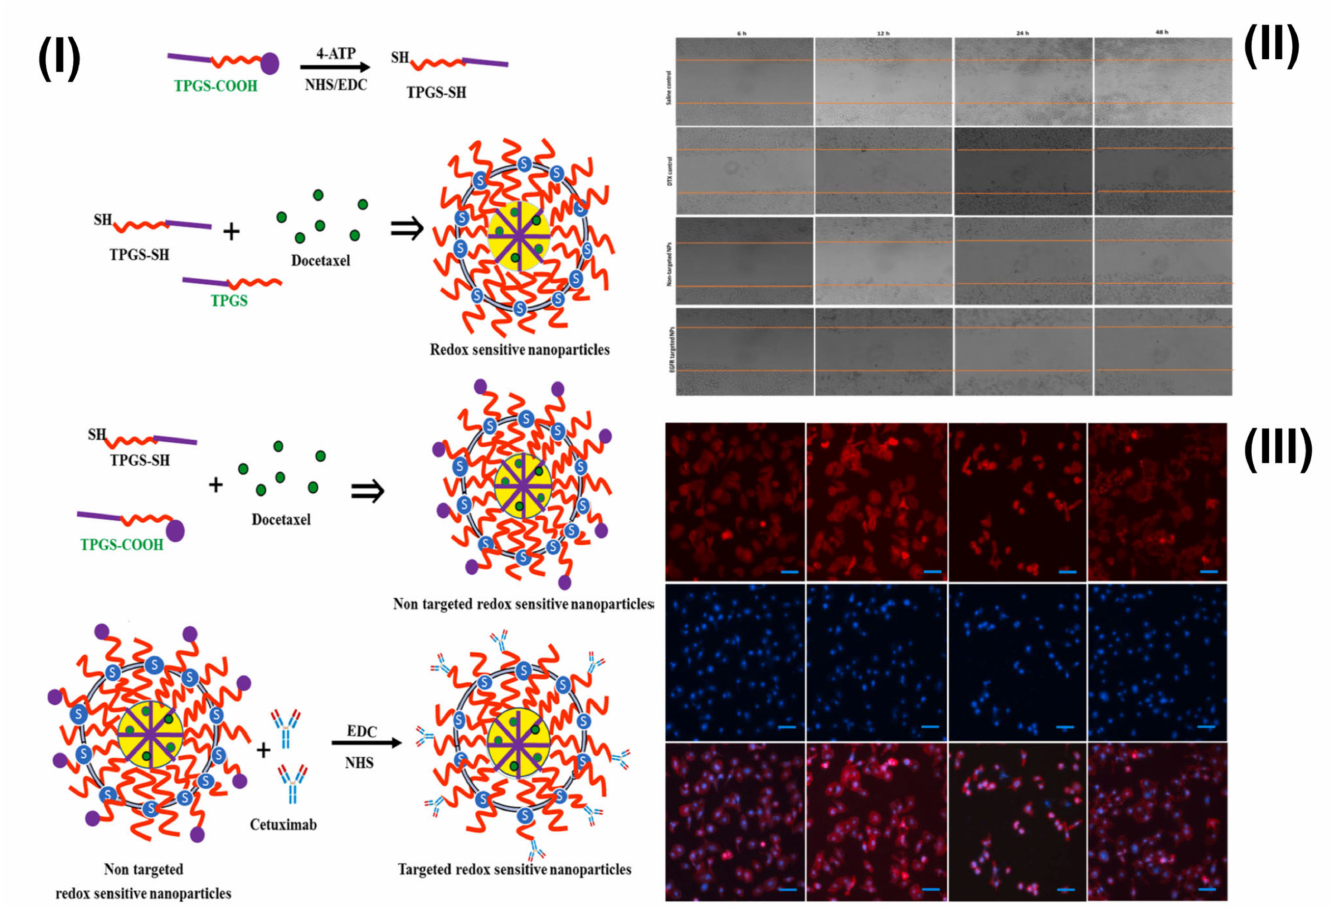
Figure 6. ( I ) Method for making redox-sensitive NPs that can be used in specific applications are described; ( II ) Wound healing assay (in vitro); ( III ) apoptosis studies (in vitro). Reproduced with permission from Ref. [61], Figures 1 and 6 (Elsevier